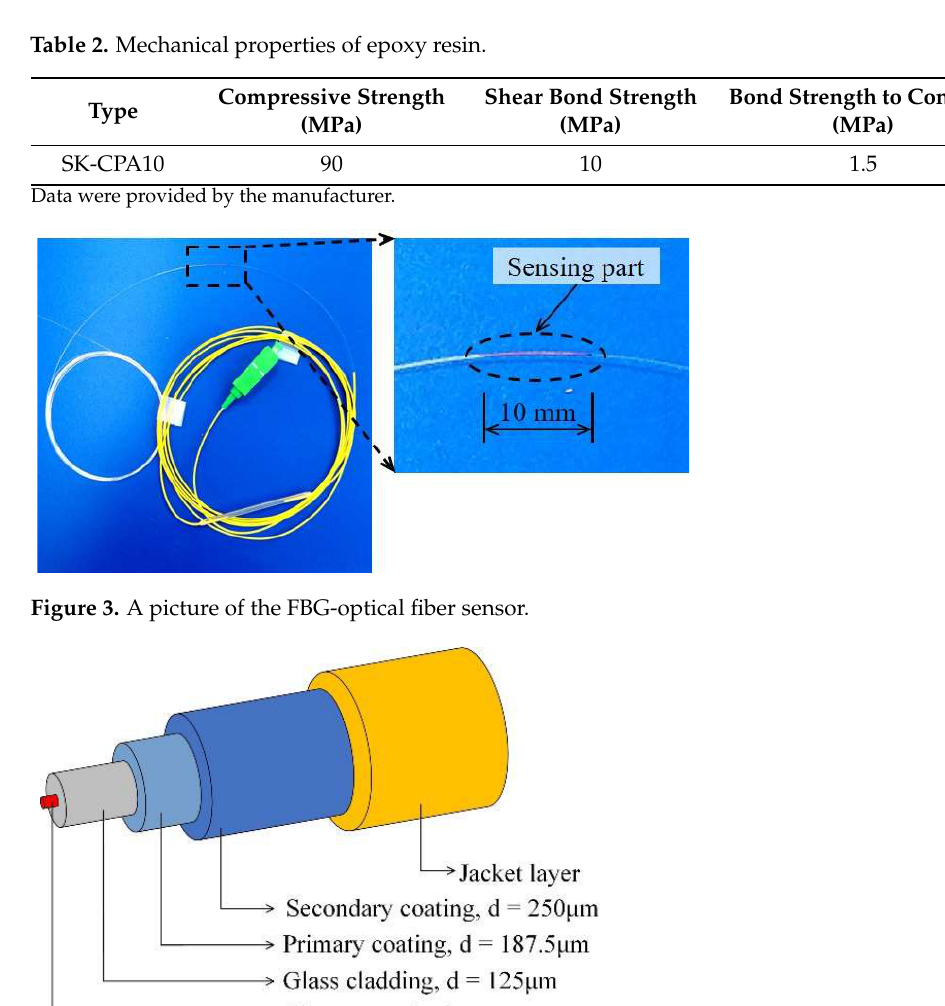
Table 2. Mechanical properties of epoxy resin.